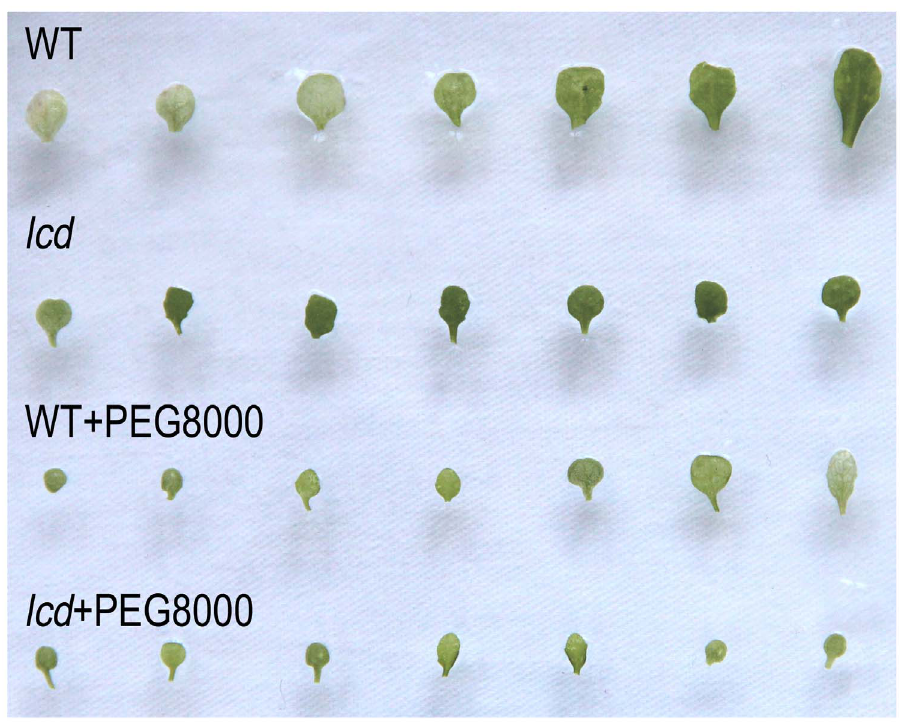
Figure 7. Leaf growth and development of WT and lcd plants treated with PEG8000. WT and lcd seedlings cultured in K MS and K MS containing PEG8000 for 26 day. Experiments are repeated three times.